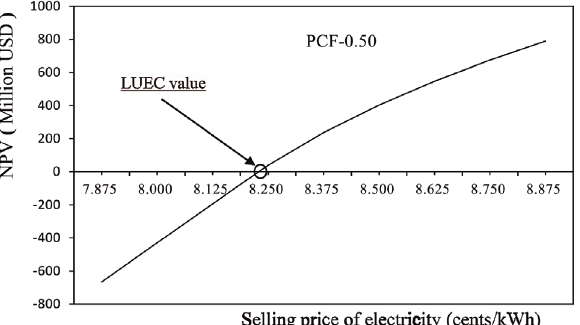
Figure 9. Comparison of LUEC with other power generating sources in Bangladesh (BPDB 2018–2019).